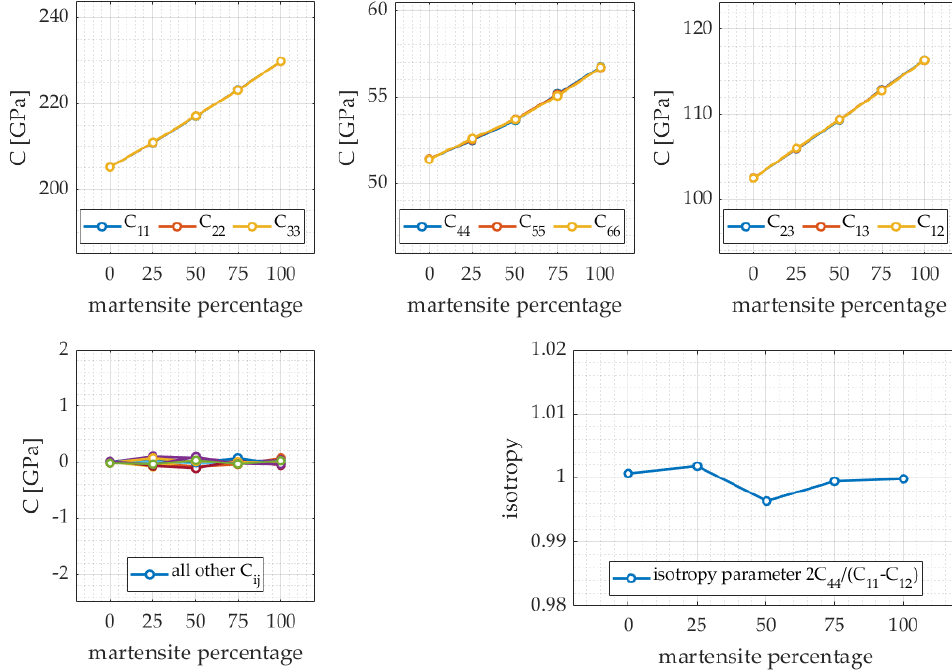
Figure 16. All polycrystal (Voigt-Reuss-Hill averaged) coefficients plotted as function of the phase ratio (in percentage of martensite, with the other phase being austenite). The bottom right curve shows the isotropy 𝒵 (cf. Equation (1)) in all five samples for a temperature of 550 °C.